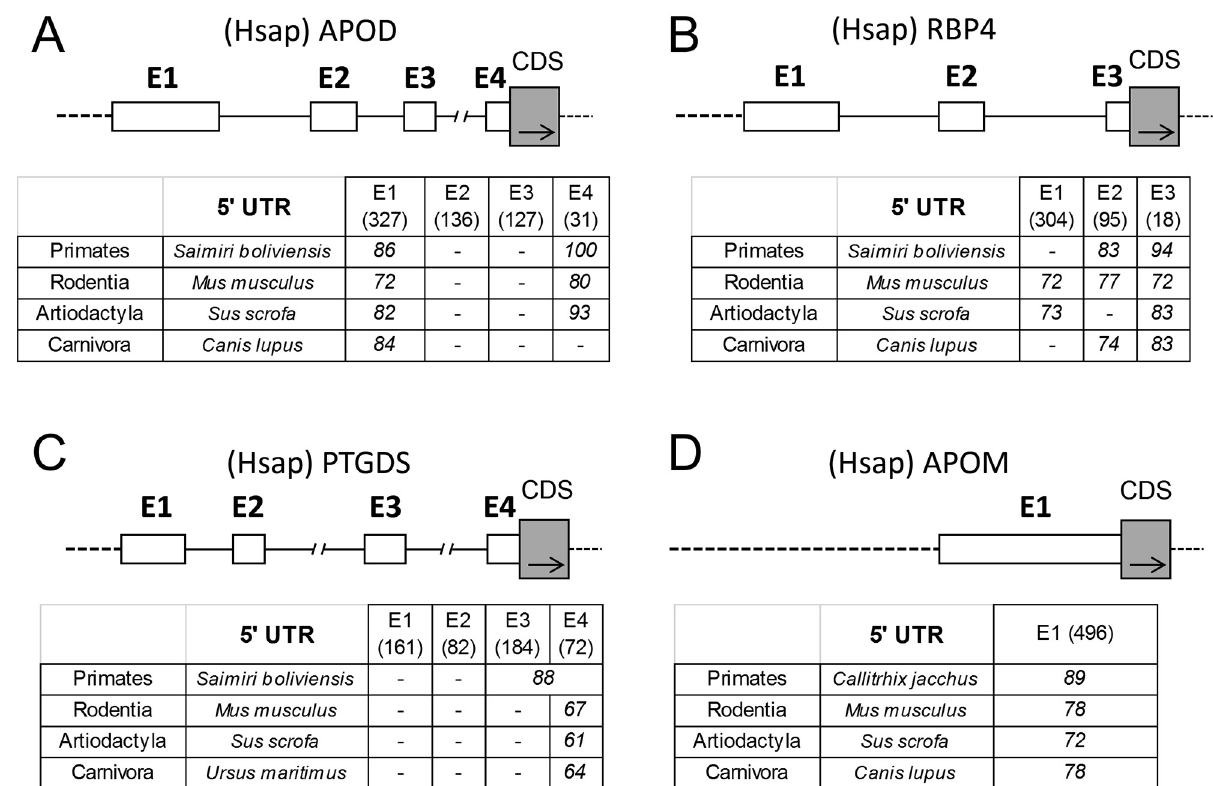
Fig 4. Sequence similarity of orthologous 5’ UTR exons. Sequence similarity between human 5’ UTR exons of APOD (A), RBP4 (B), PTGDS (C) and APOM (D) versus the orthologous ones from selected species of different mammalian orders. The complete exon-intron structure of 5’ UTR for each human Lipocalin is shown for reference. Percent identity ( � 60% identity) obtained from pairwise alignments are shown. (-): Lack of homologous exon.